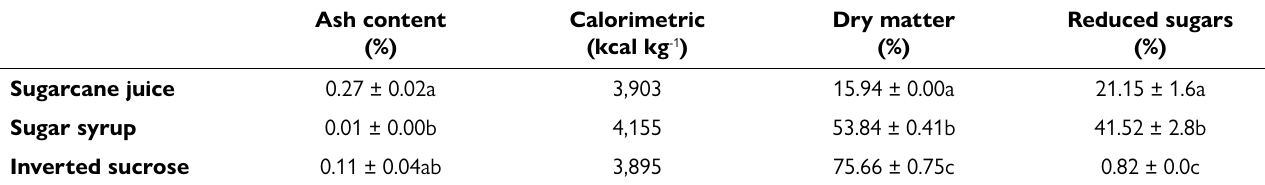
Table 2. Physicochemical analyses of different energetic foods (sugarcane juice, sugar syrup and inverted sucrose).